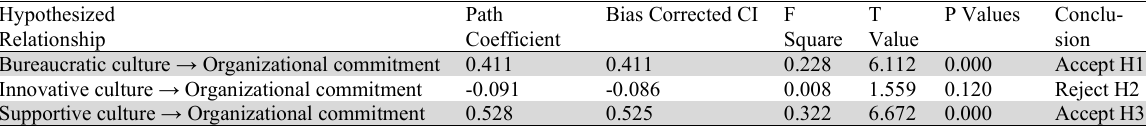
Path Bias Corrected CI F Coefficient